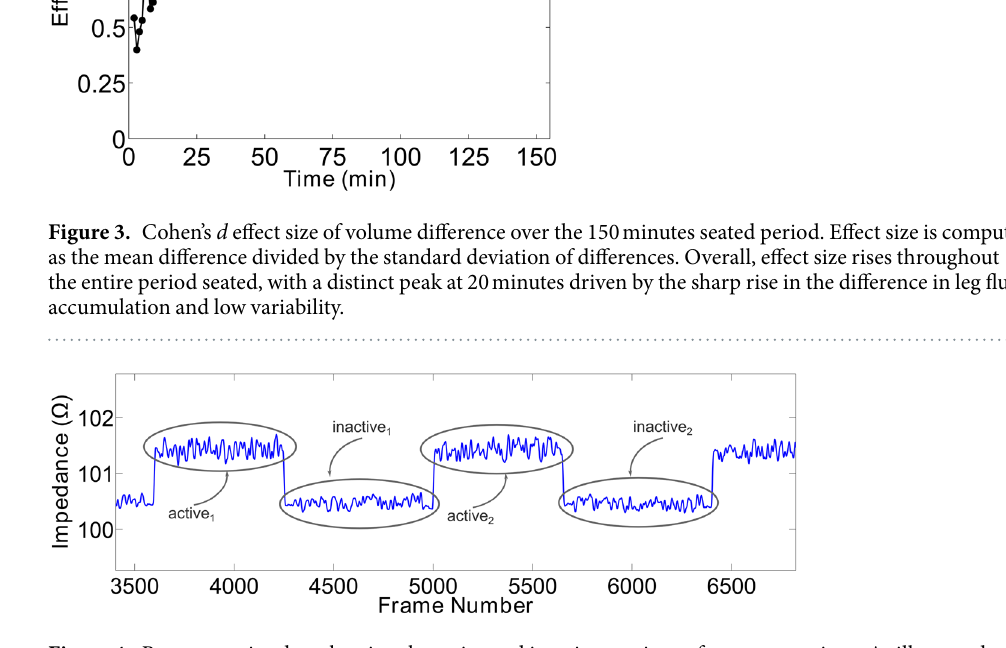
Figure 4. Representative data showing the active and inactive portions of two contractions. As illustrated, impedance increases with contraction (active) representing fluid ejection from the legs, and then drops when there is no contraction